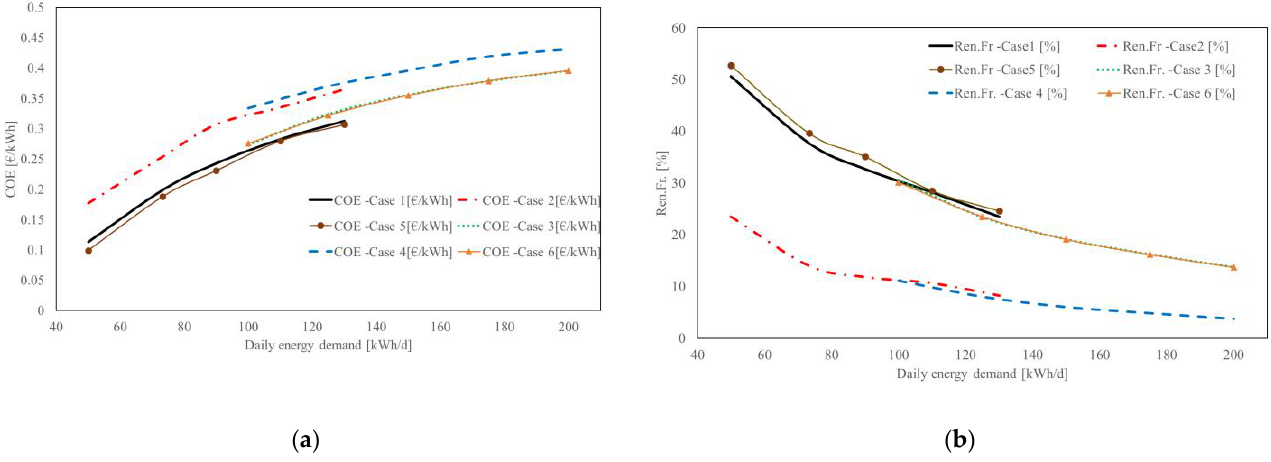
Figure 6. Load parametric study. ( a ) COE vs. energy demand; ( b ) Ren.Fr. vs. energy demand.